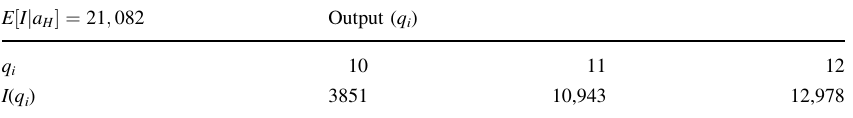
Table 2 Pay for performance when no